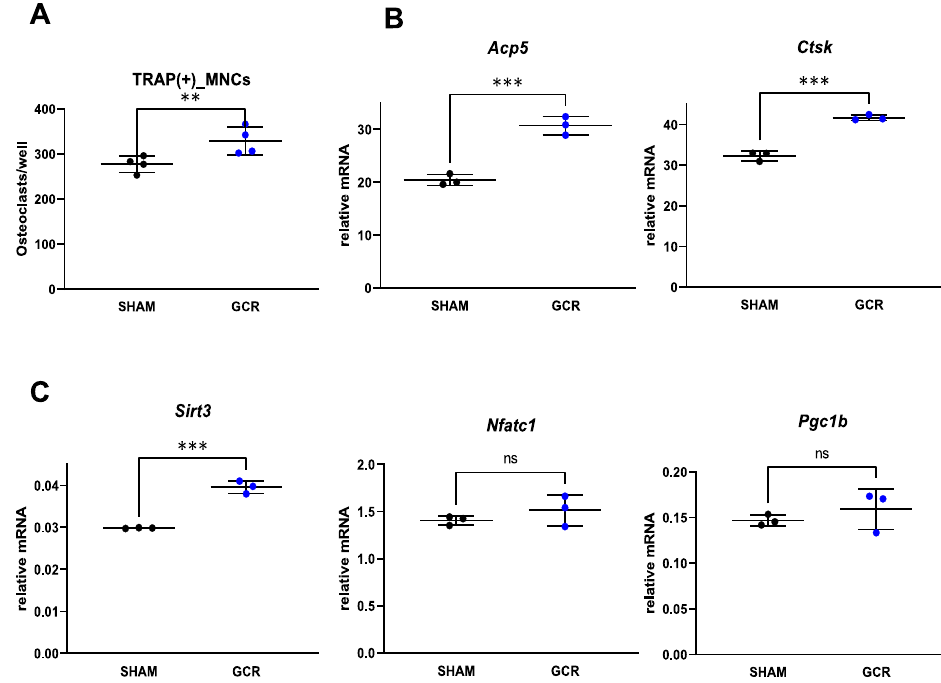
Figure 4. OC differentiation was increased when bone marrow macrophages were isolated from sham or GCR exposed mice in vitro. ( A ) Bone marrow macrophages were isolated from 9-month-old male BalbC sham or GCR exposed mice 3 months after the mice were irradiated and cultured with M-CSF (30 ng/mL) and RANKL (30 ng/mL) for 5 days. The number of TRAP+ multinucleated osteoclasts was significantly higher GCR group. ( B ) Expression of OC differentiation markers cathepsin K ( Ctsk ) and tartrate-resistant acid phosphatase type 5 ( Acp5 ) were found to be significantly increased in the GCR group. ( C ) No significant differences were noted between sham and GCR groups when mRNA levels of early OC differentiation marker Naftc1 or in mitochondrial biogenesis transcription factor Pgc1 β were measured in vitro.